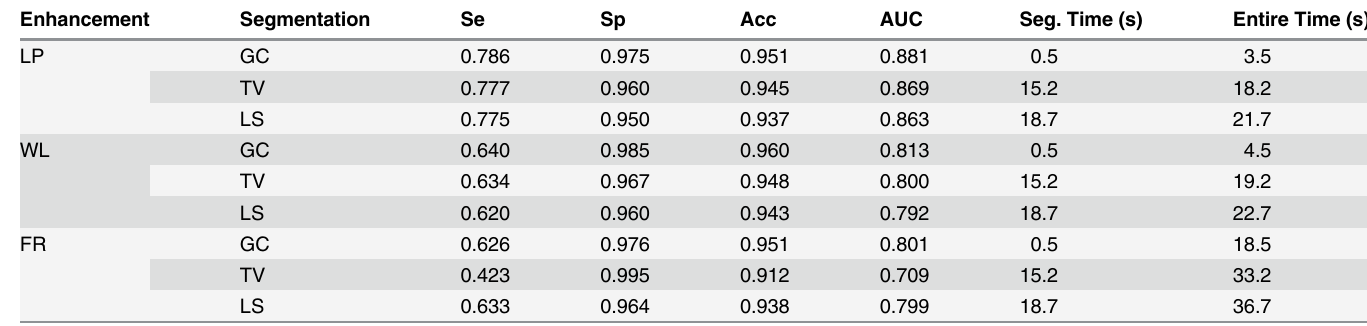
Table 3. Segmentation performance of different possible combinations of three enhancement methods (LP, WL, FR) and three segmentation meth- ods (GC, TV, LS) on the STARE dataset. LP, WL and FR denote local phase, wavelet and Frangi ’ s eigenvalue based enhancement filters respectively. GC, TV and LS denote graph cut, total variation and level set based segmentation methods respectively. Se : sensitivity; Sp : specificity; Acc : accuracy; AUC : area under the curve. Enhancement